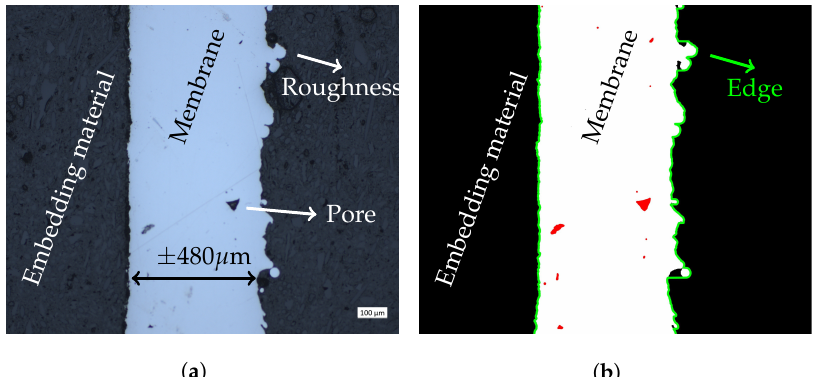
Figure 6. In figure ( a ), an image of the microscope is shown, the embedding material in black and the membrane in grey. In figure ( b ), the analysed data is visualised, in red all the detected pores, in green the detected edges, in white the membrane section and the background is black. The code calculates the roughness, the porosity (pore area compared to total membrane area) and the thickness of the membrane on a pixel count